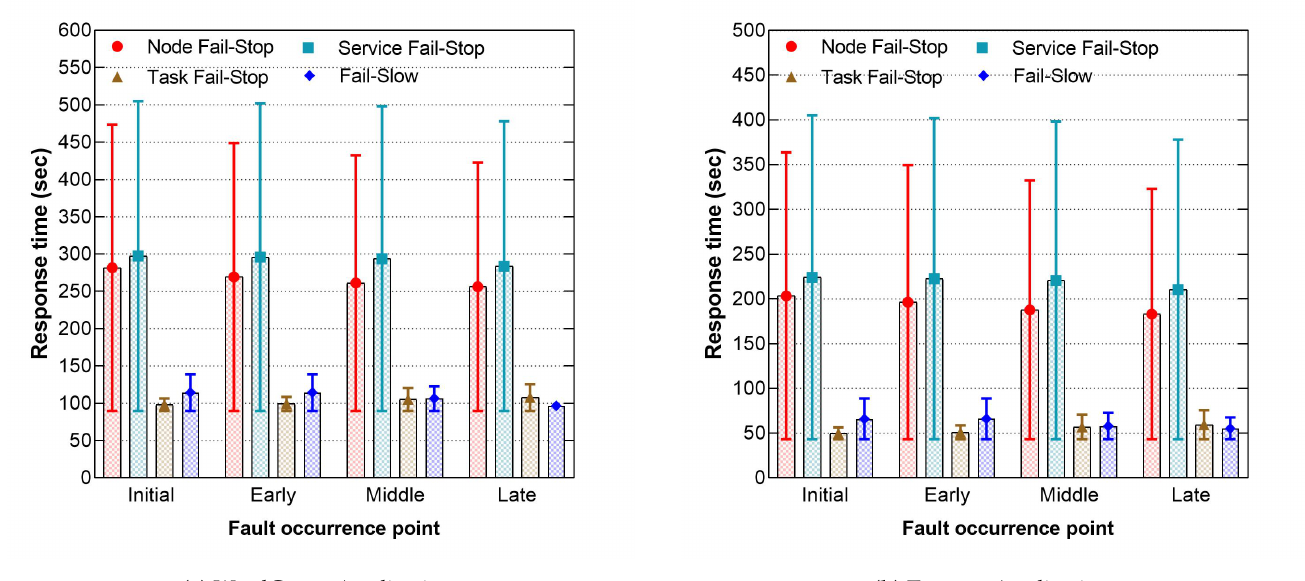
Figure 7. The response times’ differences when injecting faults at various occurrence points for WordCount and Terasort Application.